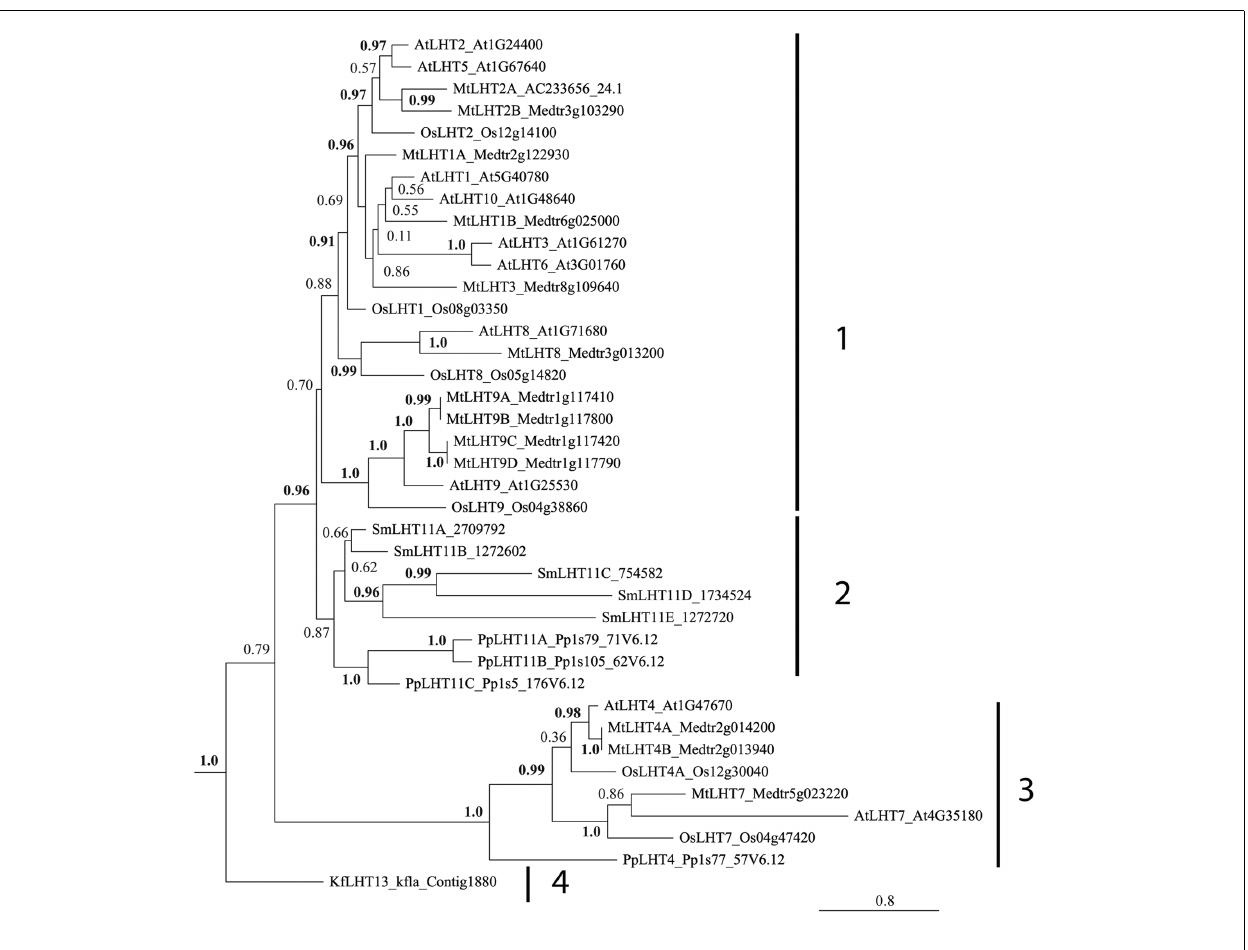
constructed using PhyML 3.0 (Guindon et al., 2010). Numbers at the nodes indicate SH-like branch support (Shimodaira and Hasegawa, 1999; Buckley et al., 2001).Values above 0.9 (in bold) show significant phylogenetic support. Accession numbers of sequences (see Table 2 ) are provided after the species transporter names.The clusters are